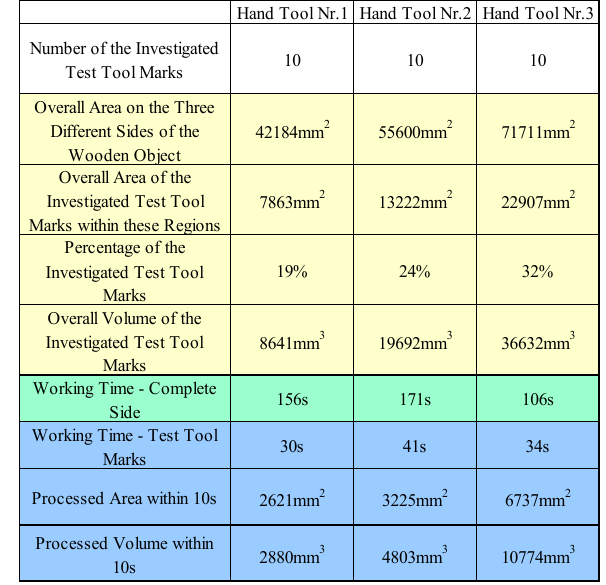
Table 3. The evaluation of the tool mark area and volume characteristics – yellow table rows: calculated values in GIS; green table row: measured time; blue table rows: estimated parameters by the known factors